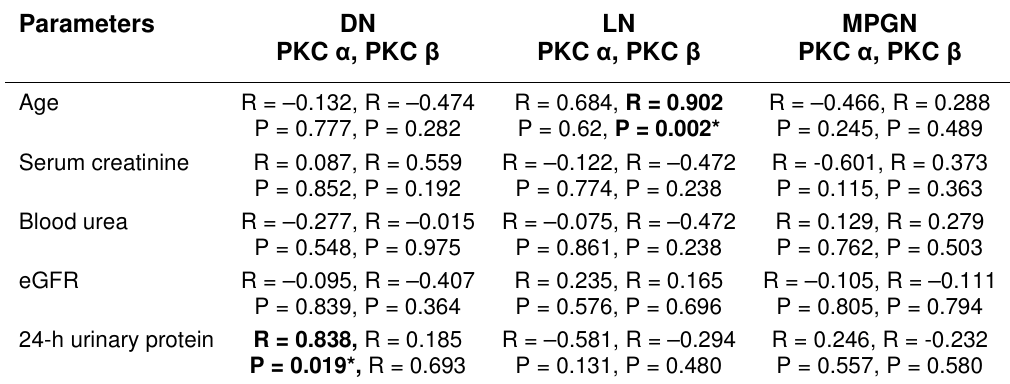
Correlation Analysis of Renal PKC α and β Levels and Baseline Patient Characteristics in the Three Study